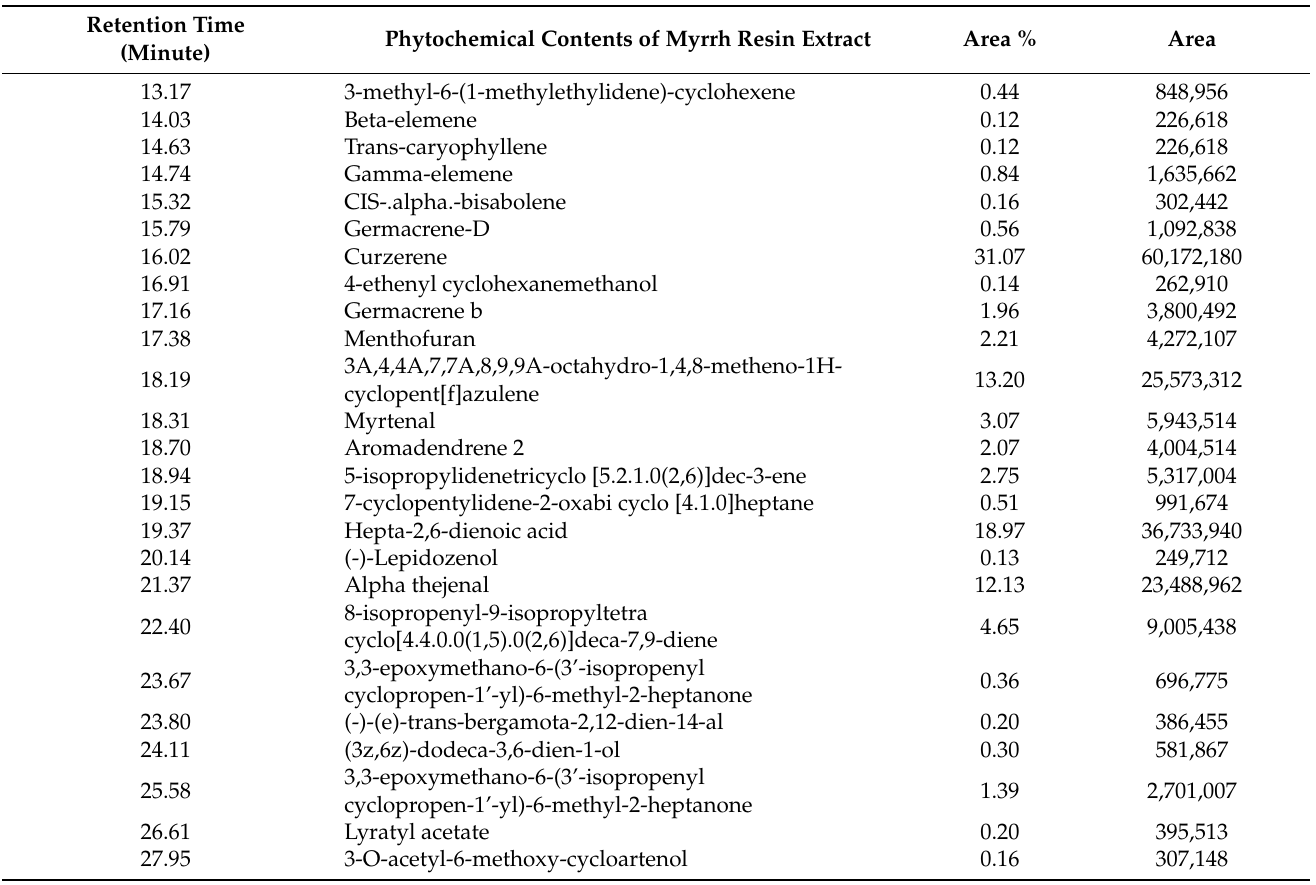
Table 1. GC–MS analysis of phytochemical contents in C. myrrha